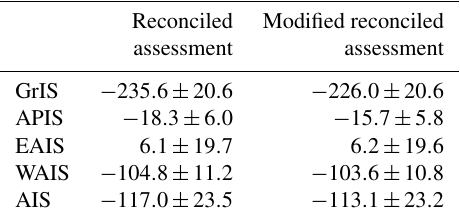
Table A2. Rates of mass change (in Gtyr − 1 ) over the gravimetry record (2002 to 2020) from our reconciled estimate and from a mod- ified version of our reconciled estimate in which the contribution of the peripheral glaciers has been removed from the gravimetry esti- mates following the method described in Sect.